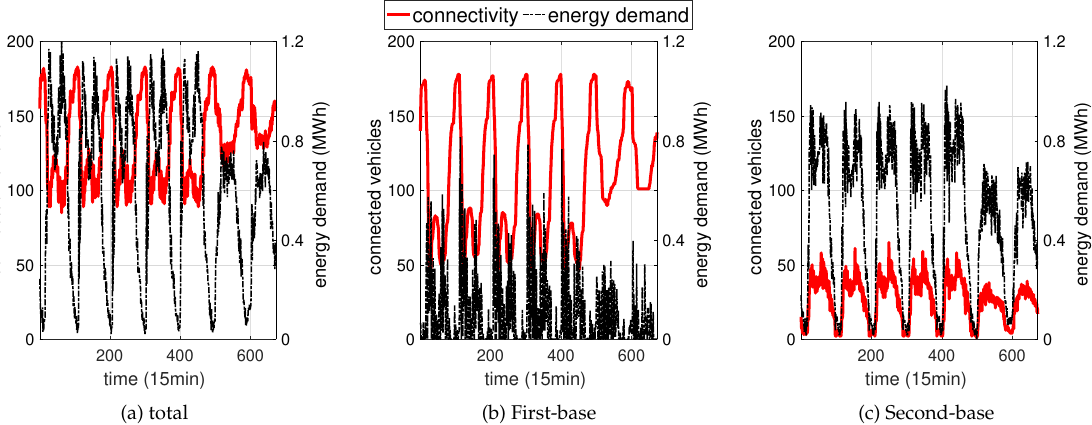
Figure 4. Energy demand of an ( a ) arbitrary electric bus fleet separated by energy demand occurring at ( b ) first base charging at the depot and ( c ) second-base charging at termini. The connectivity of the electric bus fleet is indicated by the red solid lines, while the black